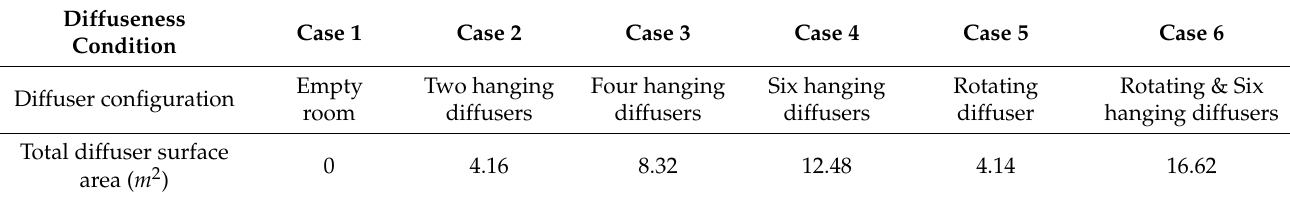
Table 2. Diffuser configurations of the reverberation chamber, including the total surface area of the diffusers. Diffuseness Condition Diffuser configura- tion